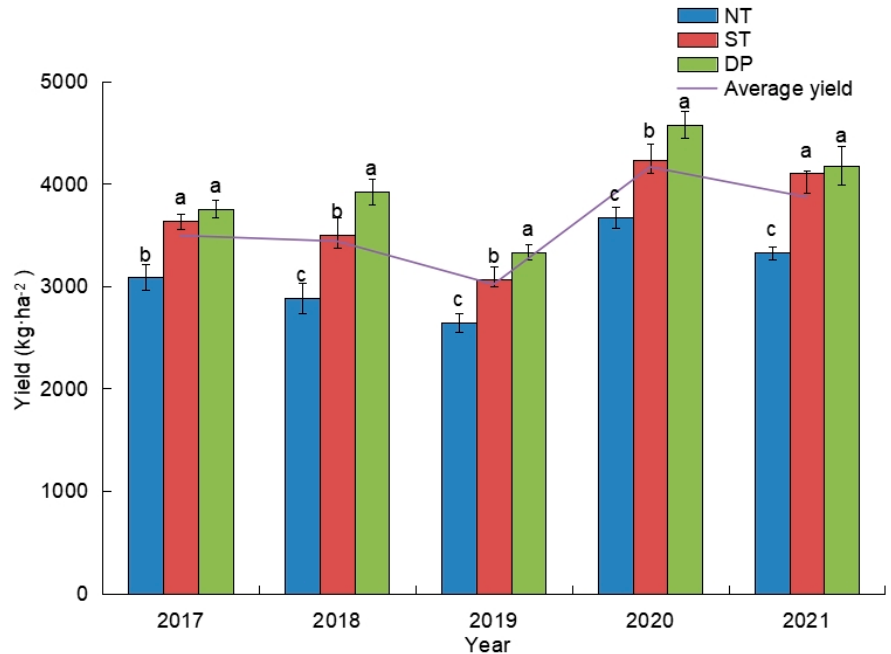
Figure 6. Effects of fallow tillage on winter wheat yield from 2017 to 2021. Different letters above bars indicate significant differences at the 0.05 level.